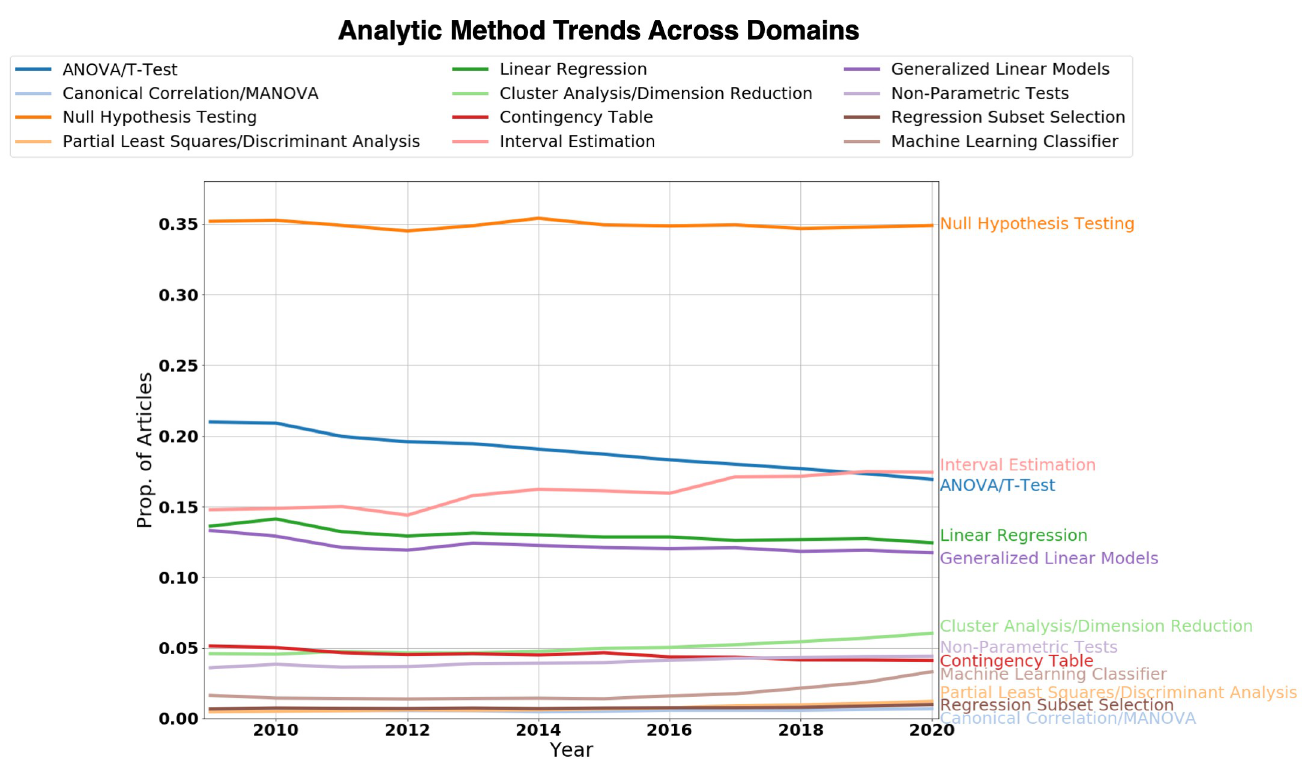
Fig 3. Overall trends in analytic methods over the past decade. Time series of 12 analytic method categories from 2009 to 2020 (annual frequency) displayed in a single line plot. For each analytic method category, the time series represents the proportion of articles that contained a mention of that category in their “Methods/ Materials” or “Results” section per year. As can be observed from the plot, baseline differences in the proportion of mentions across analytic method categories are very prominent. Overall, analytic methods taught in introductory research methods and statistics courses (e.g., null hypothesis testing, t test/ANOVA, 2-way contingency tables, linear regression, and interval estimation) have been and still are the most mentioned category of analytic methods at the end of the decade (2020). Analysis of individual trends of each analytic method category ( Fig 4 ) reveals that while dominant, “introductory” analytic methods have exhibited a decline in mentions over the past decade, while “advanced” analytic methods have shown a consistent increase in mentions. Proportion of article counts by year for all analysis methods are provided in S2 Data . ANOVA, analysis of variance; MANOVA, multivariate analysis of